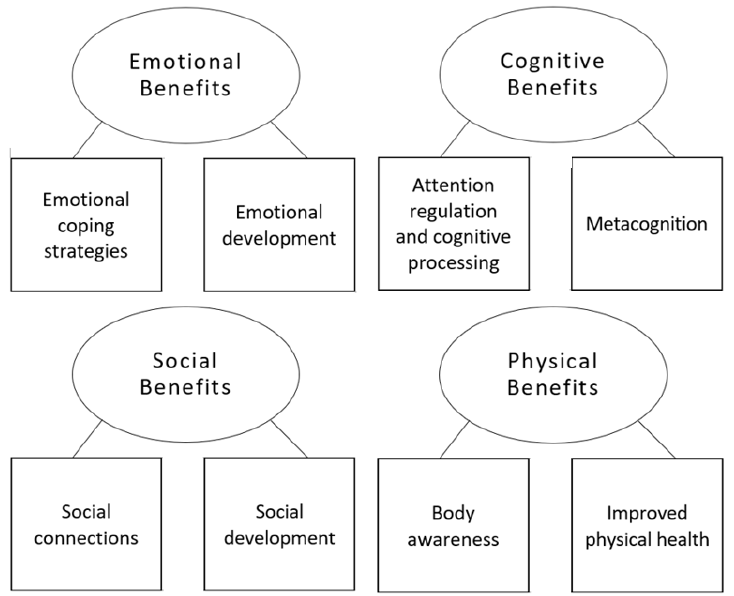
Media Depictions of Outcomes of Mindfulness in